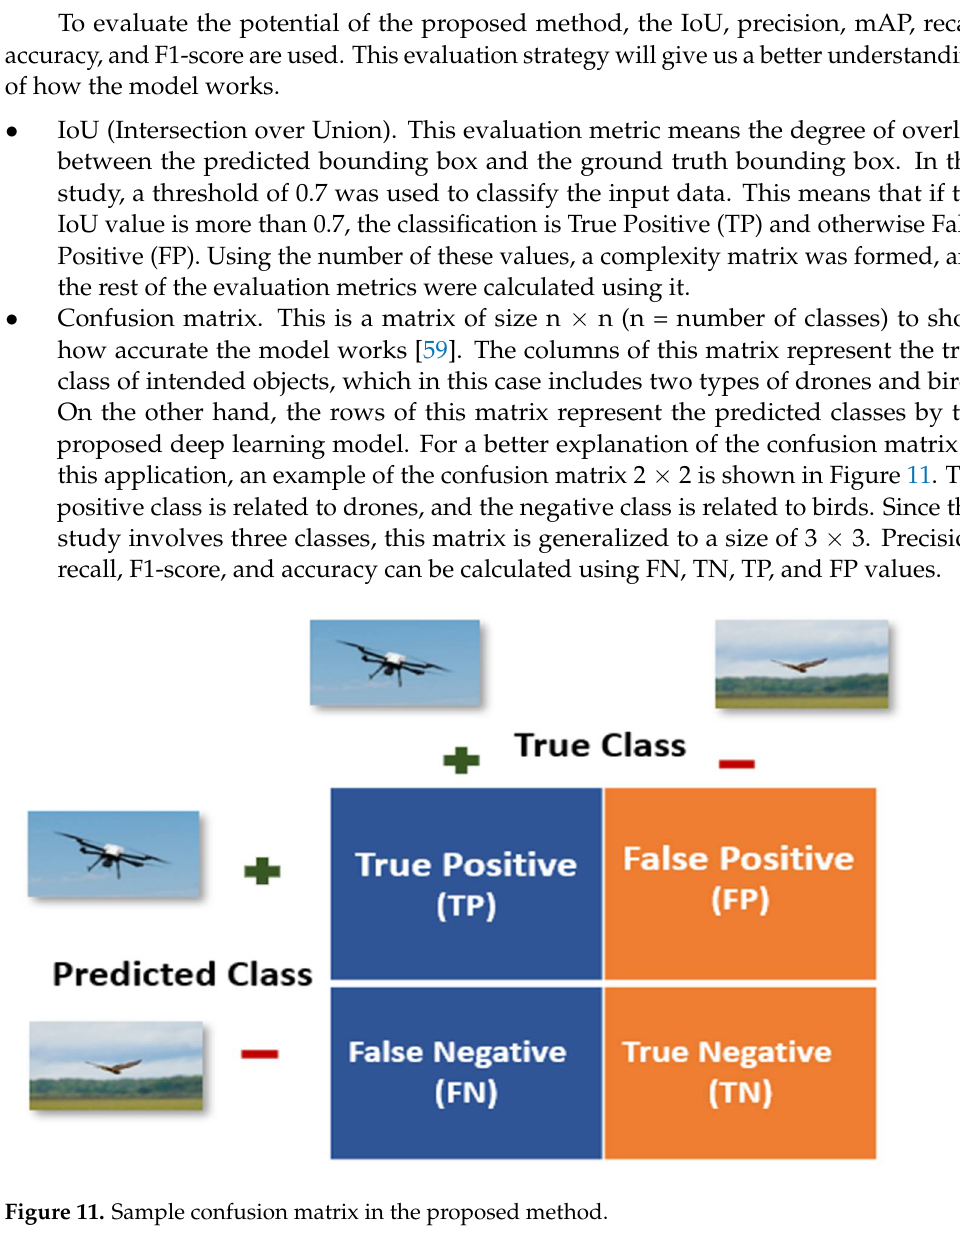
Figure 11. Sample confusion matrix in the proposed method.